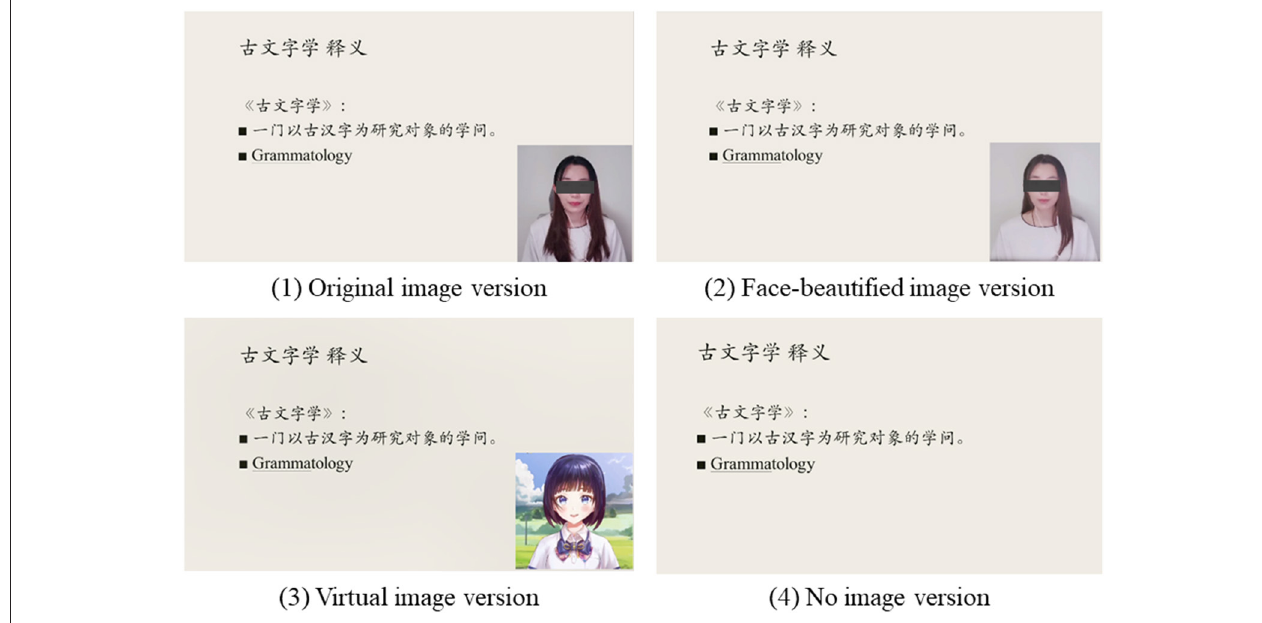
FIGURE 1 | Screen shots of the four versions in the image experiment (after privacy treatment).